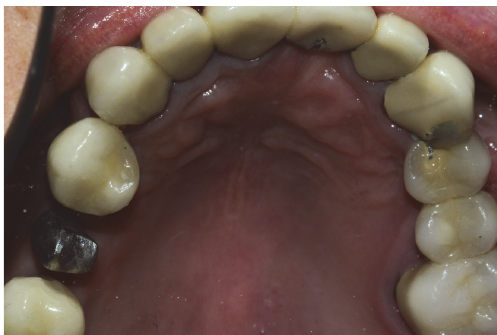
Figure 5: Post cement.